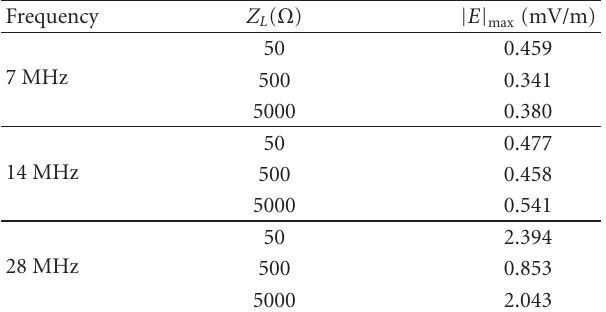
Figure 10: Radiated magnetic field. Table 1: Maximum values of the radiated electric field at the 30 m